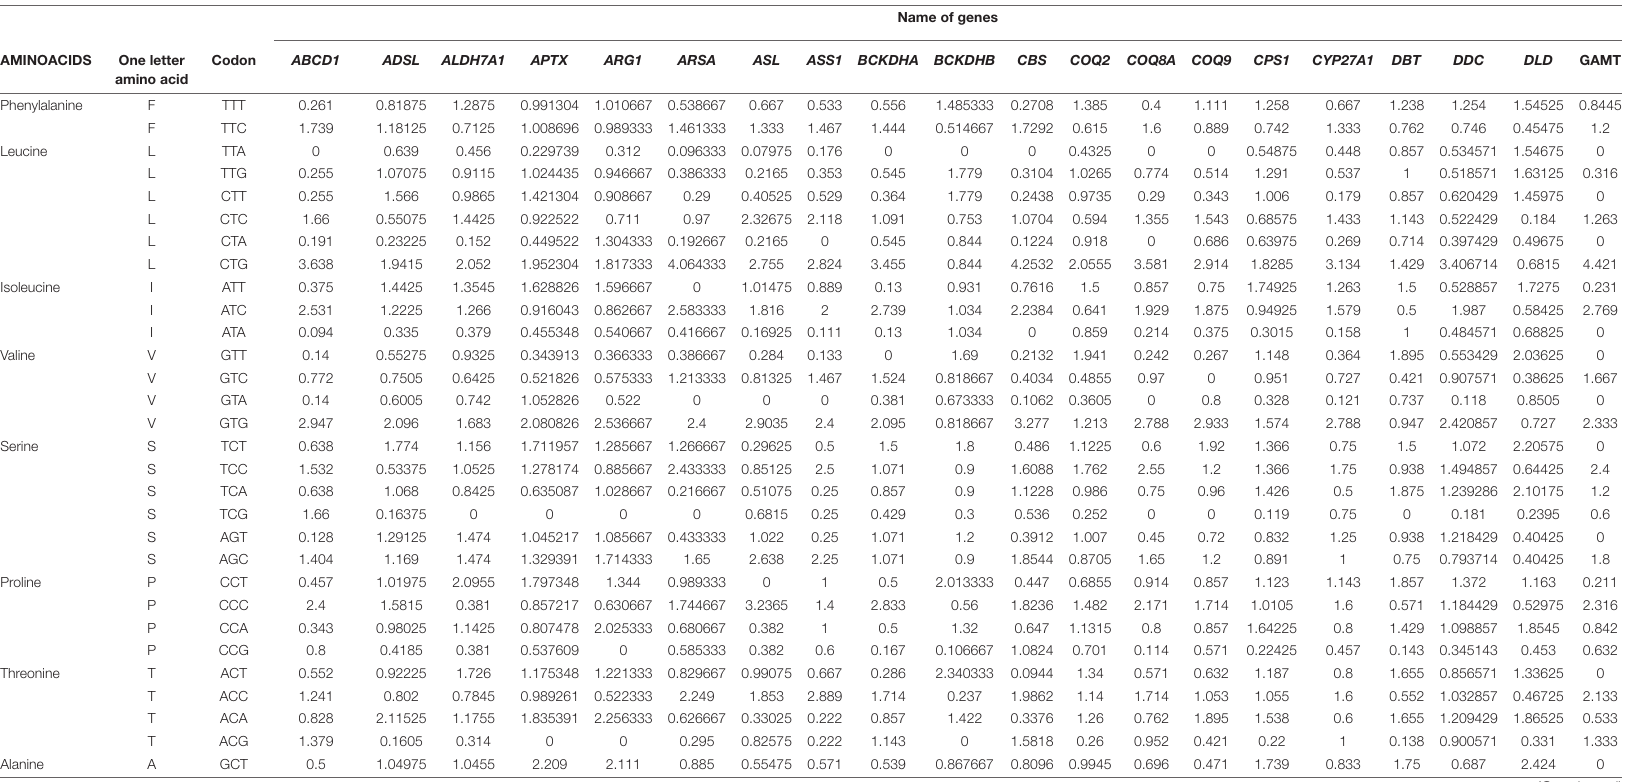
TABLE 3 | RSCU values of genes highlighting the codons with highest RSCU